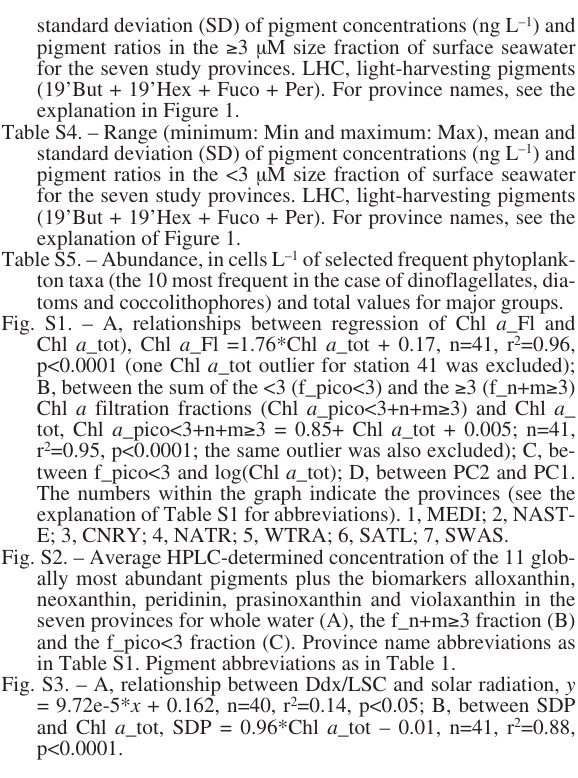
explanation in Figure 1. Table S4. – Range (minimum: Min and maximum: Max), mean and standard deviation (SD) of pigment concentrations (ng L –1 ) and pigment ratios in the <3 µM size fraction of surface seawater for the seven study provinces. LHC, light-harvesting pigments (19’But + 19’Hex + Fuco + Per). For province names, see the